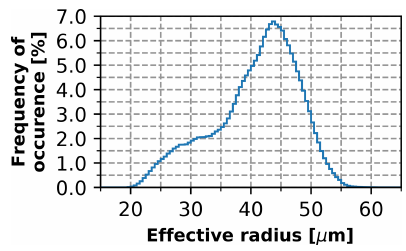
Figure 19. Histogram of the ice particle effective radius for PS106. Integration over x yields